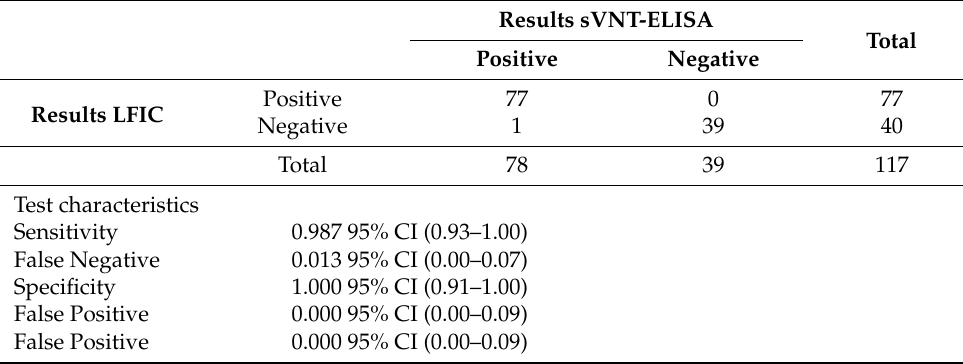
Table 3. Sensitivity and specificity, with 95% confidence intervals (CIs), for LFIC test.